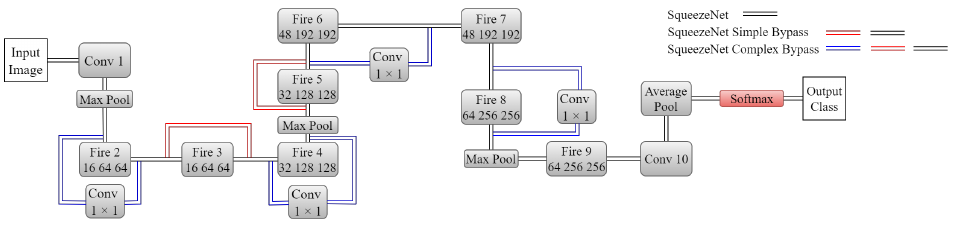
Figure 15. SqueezeNet architectures.